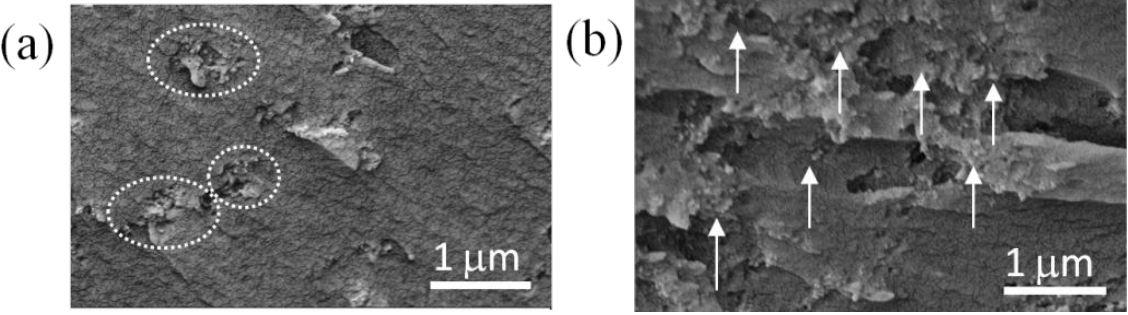
Figure 7. SEM images of ( a ) the nanocomposite with as-received nanoparticles; and ( b ) the nanocomposite with plasma polymer coated nanoparticles. Nanoparticle agglomerations are marked in ( a ) by dotted circles and well-dispersed nanoparticles are pointed by arrows in ( b ).